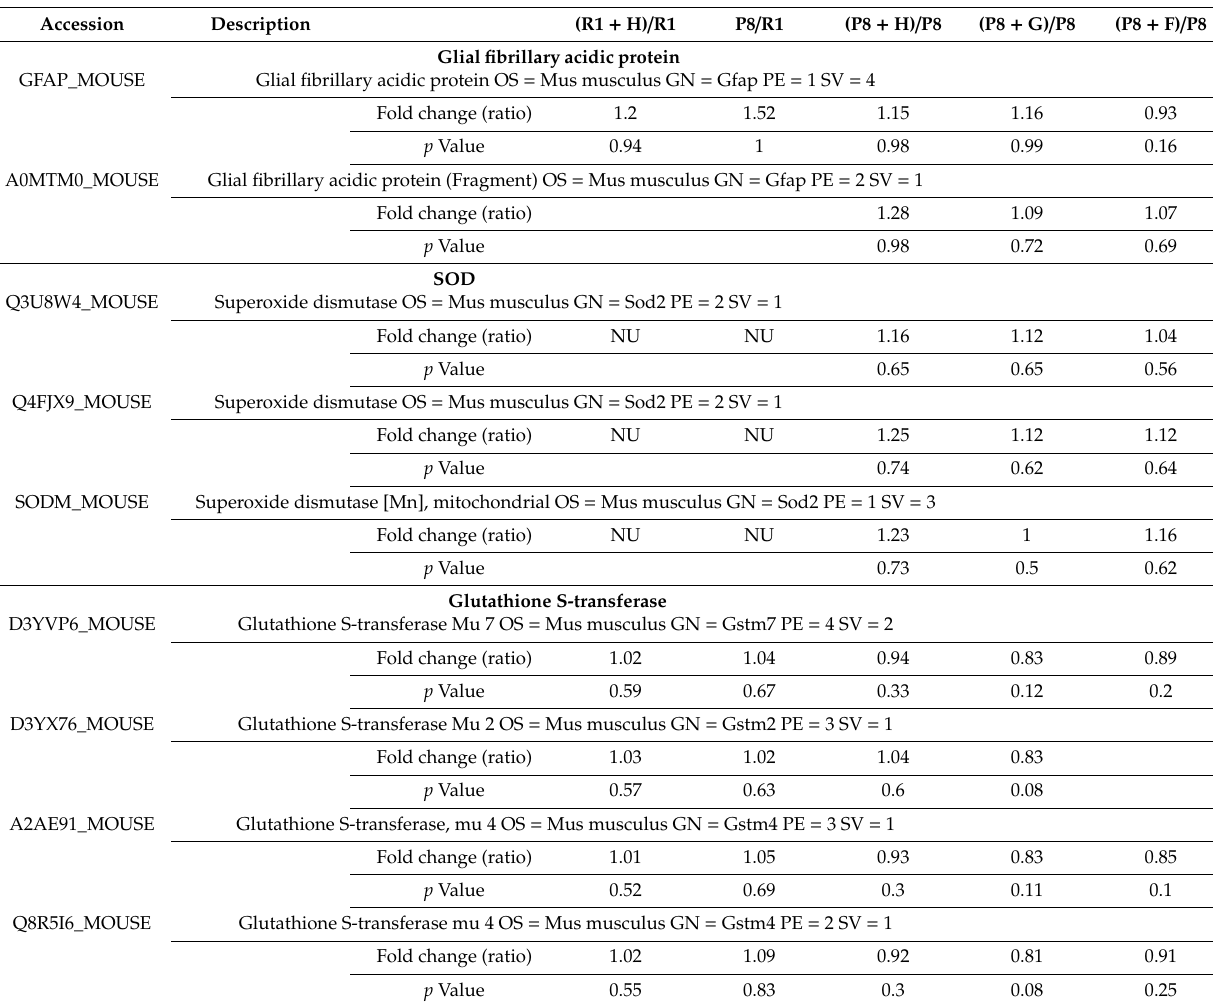
Table 2. E ff ects of the feeding of peanut wholegrain, its germ-rich fraction, and ferulic acid on the amounts of protein expression in the hippocampus of